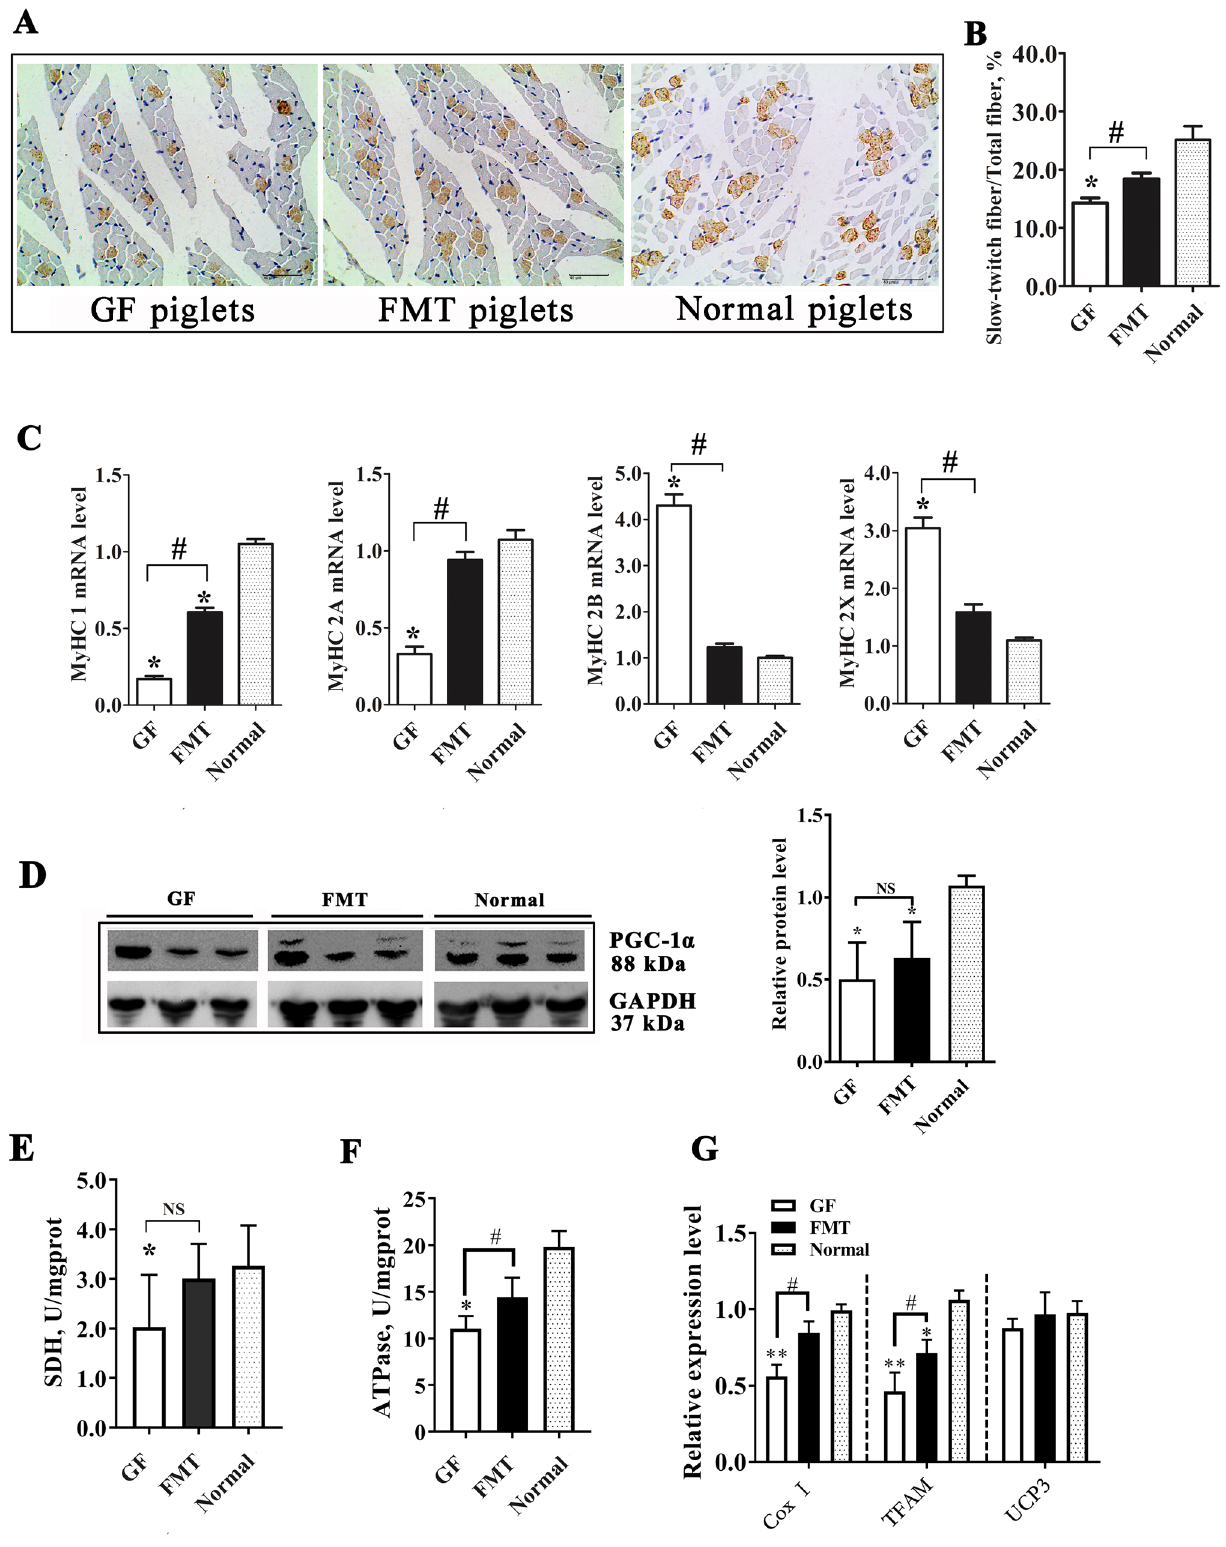
Figure 7. Change in the muscle fiber type in GF piglets. ( A ) Immunohistochemical analysis of muscle samples. The brown spots indicate slow-twitch muscle fibers. ( B ) Proportion of slow-twitch muscle fibers in the total muscle fibers. The full-length blots are presented in Supplementary Fig. 2. ( C ) mRNA levels of different MyHC genes in the muscle tissues of piglets were detected by qRT-PCR. ( D ) Protein level of PGC-1α and relative quantitative analysis of the protein level. ( E ) Enzyme activity of succinate dehydrogenase (SDH) in muscle. ( F ) Enzyme activity of Na + K + -ATPase in muscle. ( G ) Changes in the expression of the cytochrome c oxidase I (Cox I), transcription factor A mitochondrial (TFAM), and uncoupling protein 3 (UCP3) genes in muscle tissue. N = 3, the data are presented as the means ± s.e.m. * P < 0.05, ** P < 0.01 compared to the normal piglets (control). # P < 0.05 between the GF piglets and FMT piglets. NS not significant, GF piglets germ-free piglets, FMT piglets GF piglets with fecal microbiota